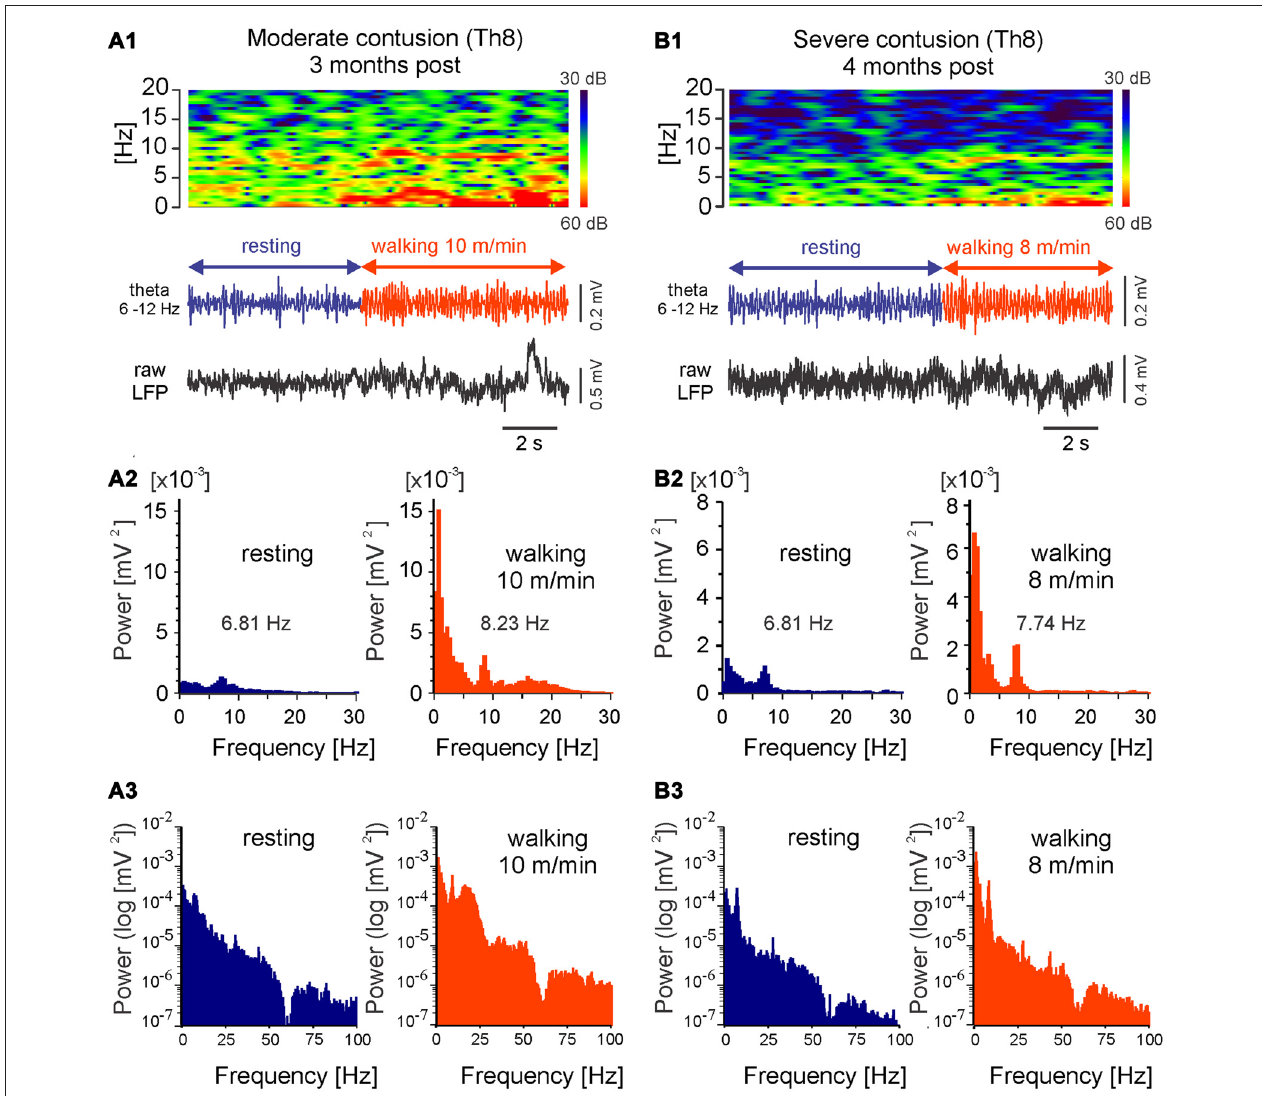
FIGURE 8 | LFPs recorded from LowTh sites in rats with moderate or severe mid-thoracic contusion SCI show similar correlation to locomotor speed as intact animals. Top in (A1,B1) : frequency spectrogram plot vs. time; bottom in (A1,B1) : LFP, filtered 6–12 Hz and raw; (A2,B2) : histograms of power spectra in linear scale; (A3,B3) : histograms of power spectra in logarithmic scale. Note increased power within the theta band ( < 12 Hz) and shift in the dominating theta frequency with the transition to